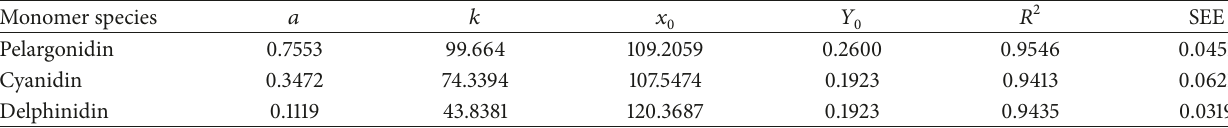
Table 1: Regression parameters of degradation kinetic of anthocyanin monomer in (7). Monomer